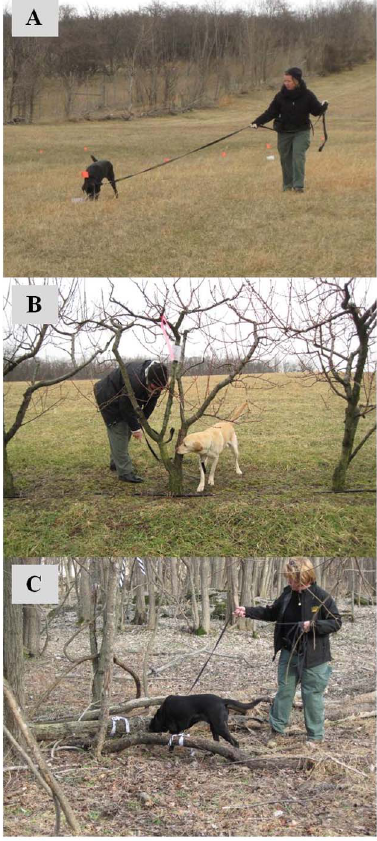
Figure 1. Canine detection of Halyomorphahalys concealed on the ground (A), concealed on the live peach trees (B),